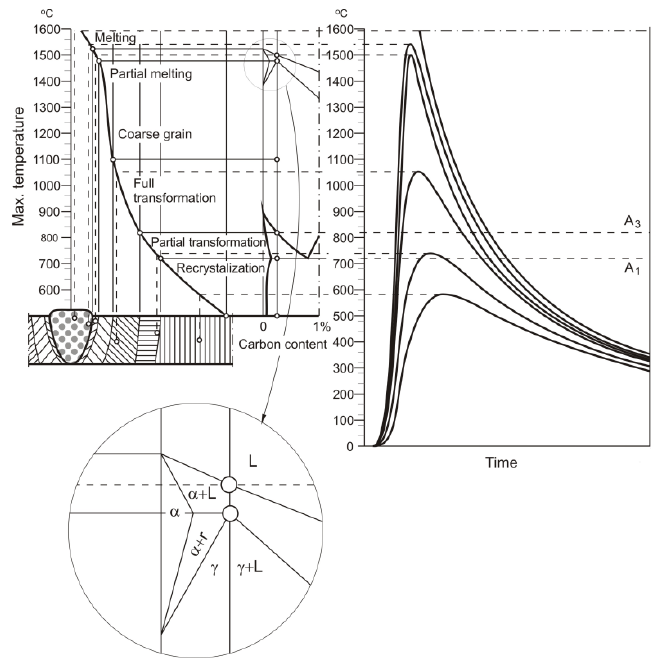
Figure 1. Characteristic structural areas of a welded joint, depending on the temperature and the share of the carbon in the steel.